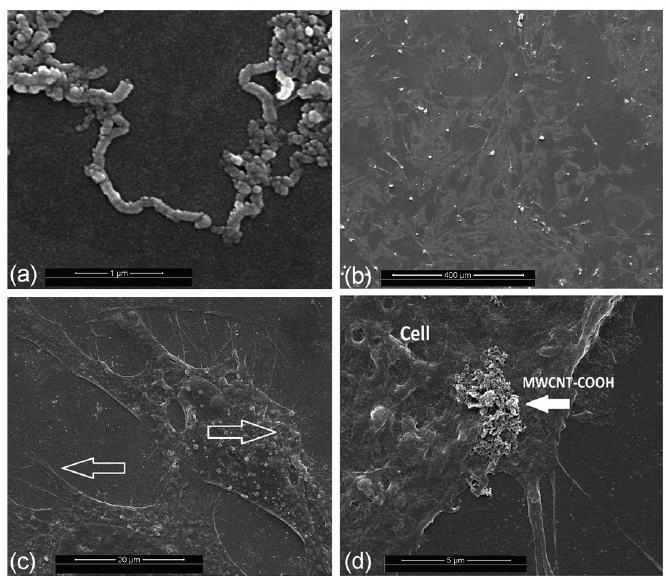
Figure 2. Representative images showing the characteristic features of MWCNT-COOH ( a ) and cementoblasts cultured with it ( b – d ): ( b ) cells were able to adhere and spread well in all directions with normal morphology; ( c ) numerous filopodia and microvillosities were extended from the cells; ( d ) higher magnifications show cell attachment to clusters of MWCNT-COOH.